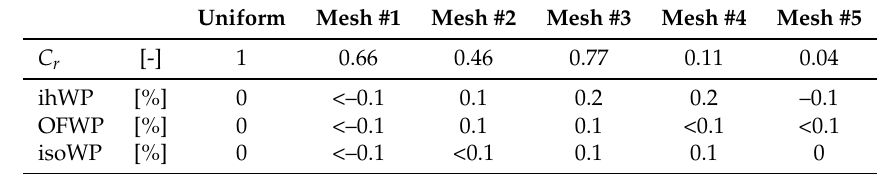
Table 7. Relative deviation of phase average wave height for different mesh layouts.